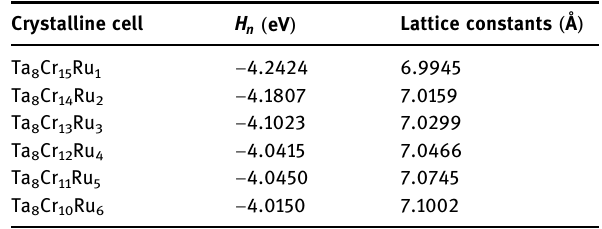
Table 1: Cell parameters for Ta atom and C15 – TaCr 2 alloy